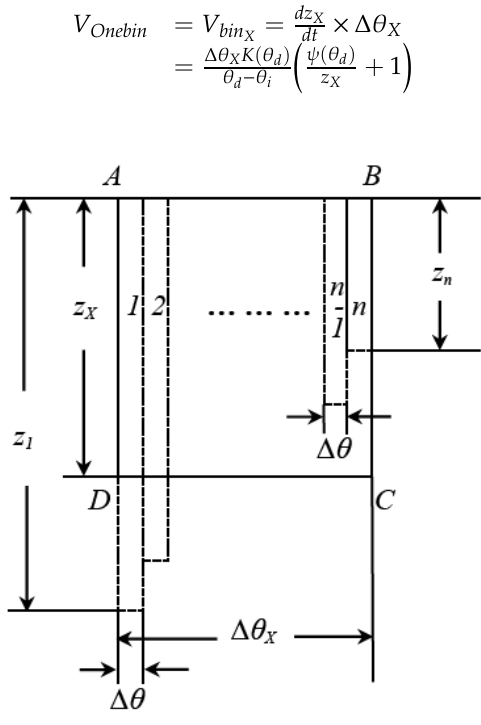
Figure 6. One bin versus n bins.